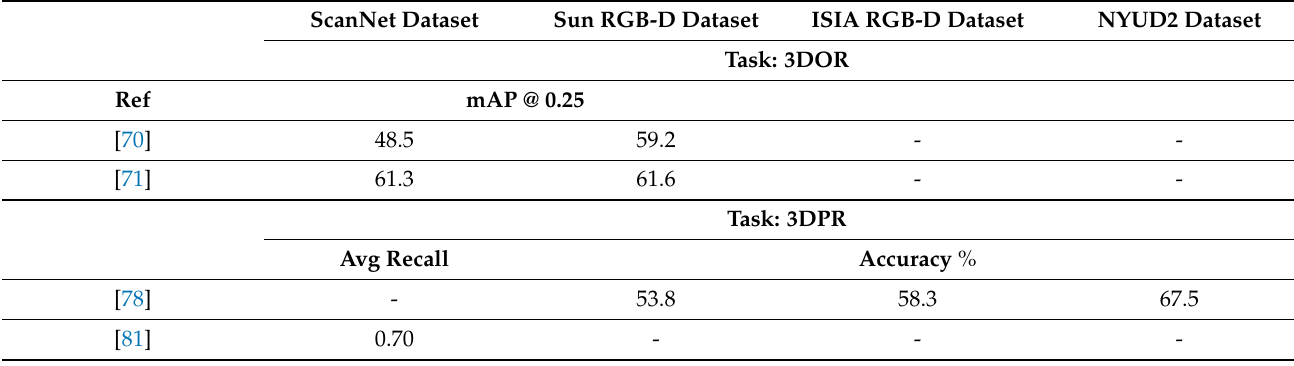
Table 27. Comparison of the Results on the ScanNet, Sun RGB-D, ISIA RGB-D, and NYUD2 Datasets.